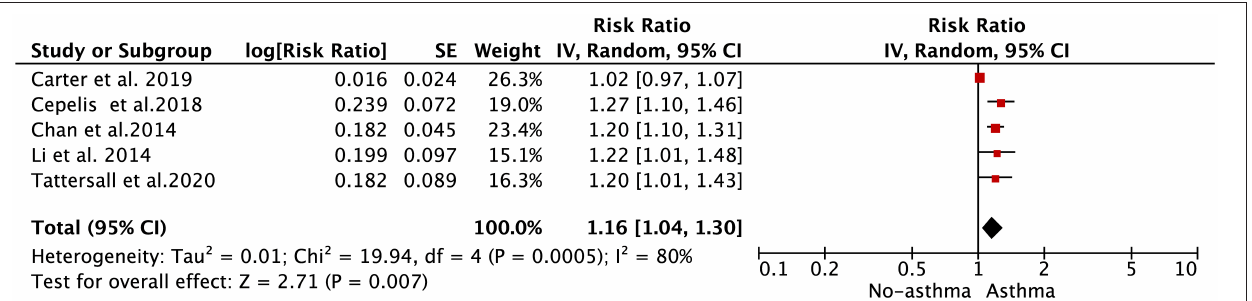
FIGURE 3 | Forest plot for the relationship between asthma and the development of atrial fibrillation.